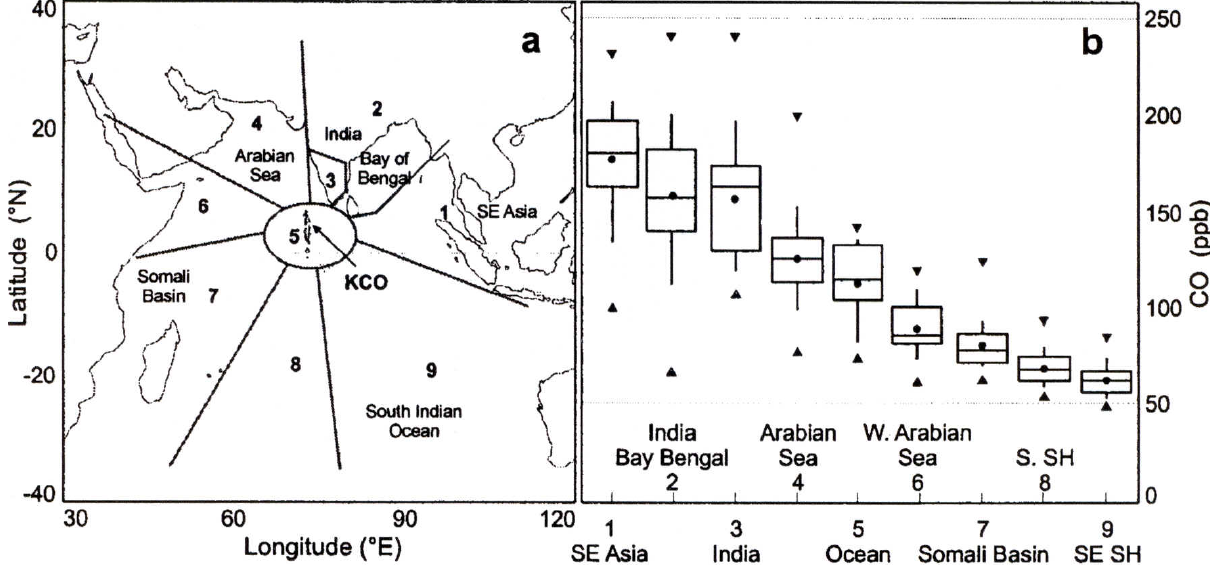
Fig. 29. (a) Key air mass flow bins for Kaashidhoo Climate Observatory (KCO) and (b) daily mean CO mixing ratios distributed over these nine air mass flow bins. The boxes describe the upper and lower quartile, the solid dot is the mean, and the bar is the median. The whiskers are the 10% and 90% quantiles, and the black triangles are minima and maxima (from Lobert and Harris, 2002, copyright 2002 by the American Geophysical Union, reproduced with